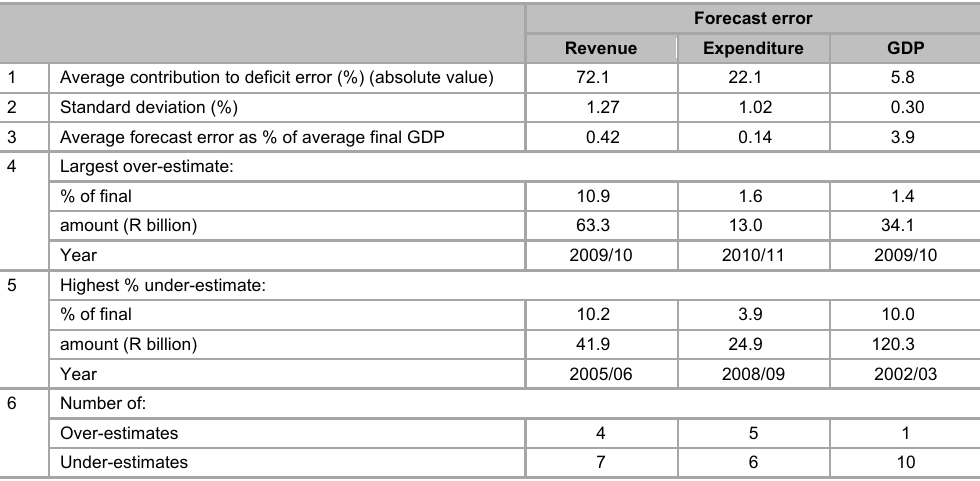
The contribution of variations in government revenue, government expenditure and GDP to budget- balance/GDP forecast errors,